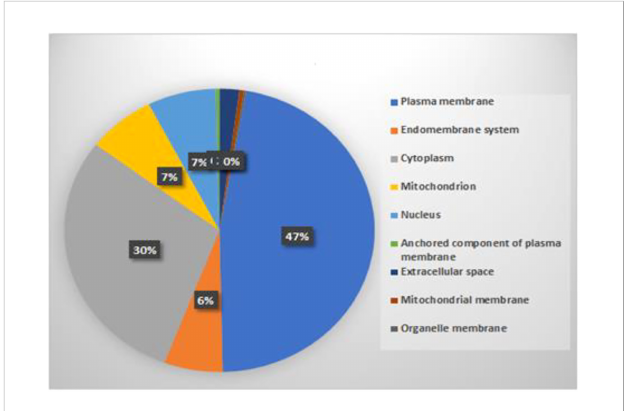
FIGURE 9 Distribution of predicted rice proteins in subcellular